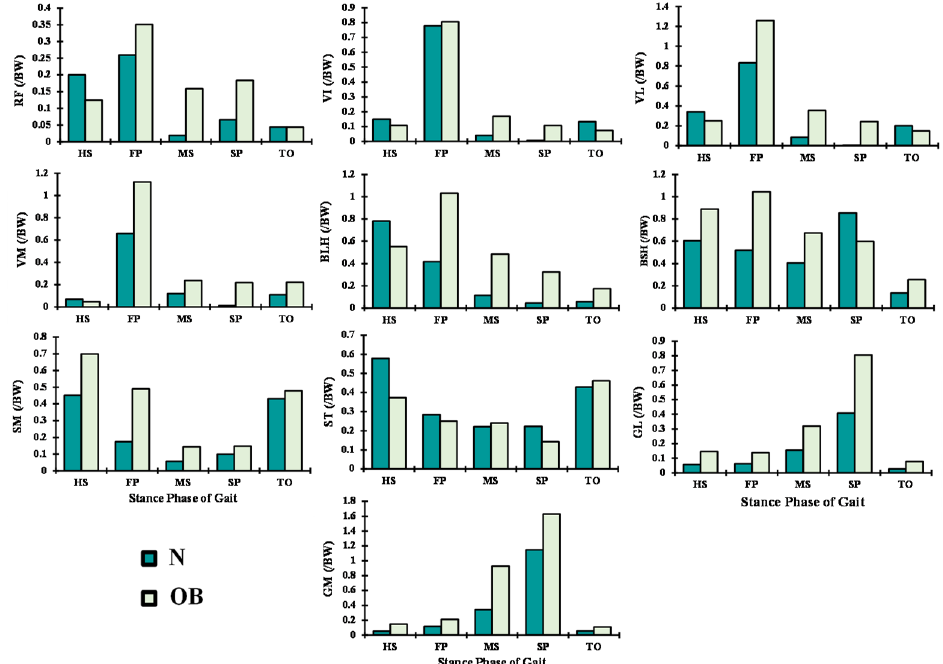
Figure 5. Predicted muscle forces at different periods of stance phase time for normal (N) and obese subjects (OB). Quadriceps: rectus femoris (RF), vastus intermidus (VI), vastus medialis (VM), and vastus lateralis (VL); hamstrings: biceps femoris long and short head (BLH and BSH), semimembranous (SM), and semitendinosus (ST); gastrocnemius: medial (MG) and lateral (LG).